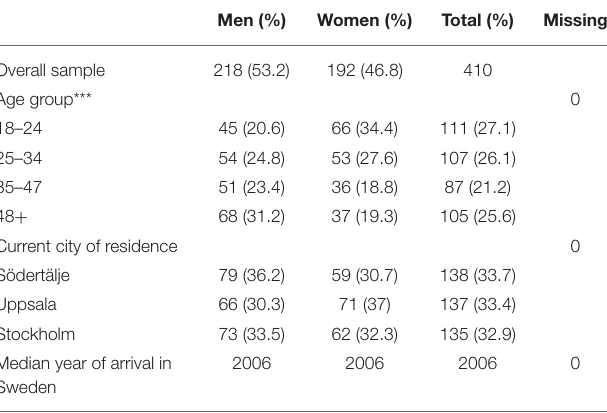
TABLE 1 | Frequency and percentage for age, residence, and arrival, by gender.